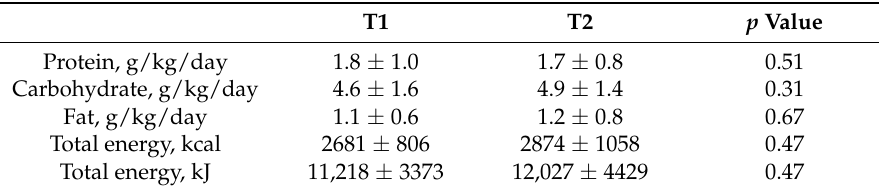
Table 2. Macronutrient dietary intake between T1 and T2